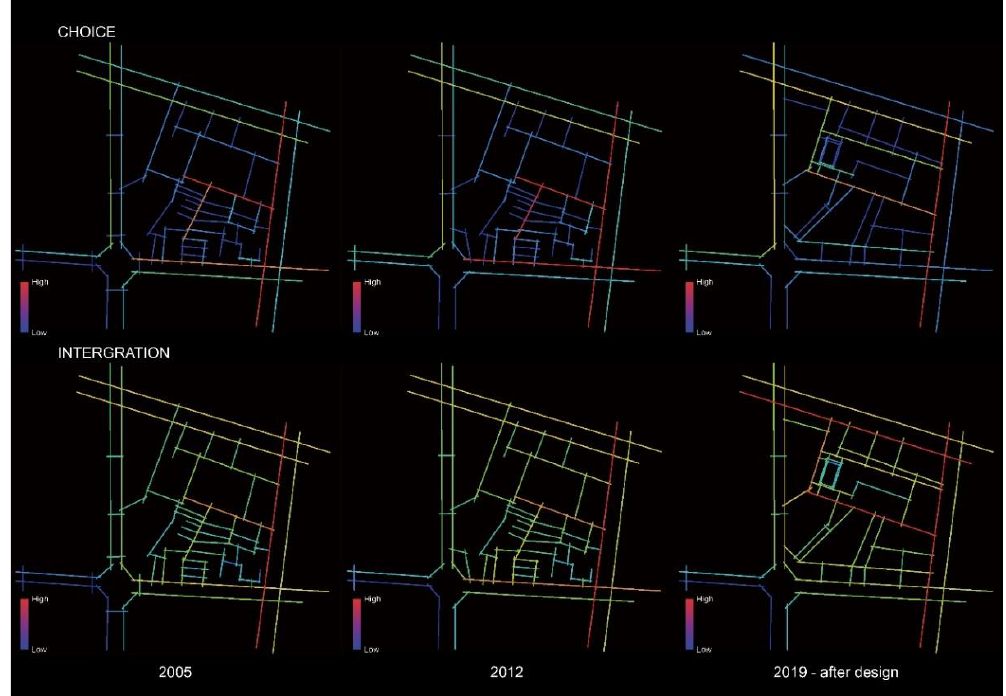
Figure 8. Spatial accessibility and choice analysis, from 2005 to 2012 to 2019.